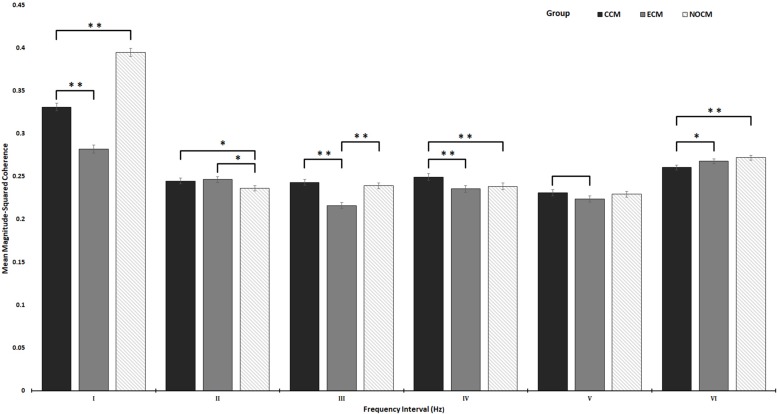
Comparison of the mean magnitude-squared coherence in the six frequency intervals between the three groups (CCM, ECM, NOCM), frequency intervals represent an equal distribution of wavelet coherence between EEG and NIRs signal data as six frequency intervals I: 0 – 0.06, II: 0.06 – 0.13, III: 0.13 – 0.4, IV: 0.2 – 0.26, V: 0.26 – 0.33, VI: 0.33 – 0.4 Hz; significant differences between the groups are marked ∗p < 0.05, ∗∗p < 0.001.